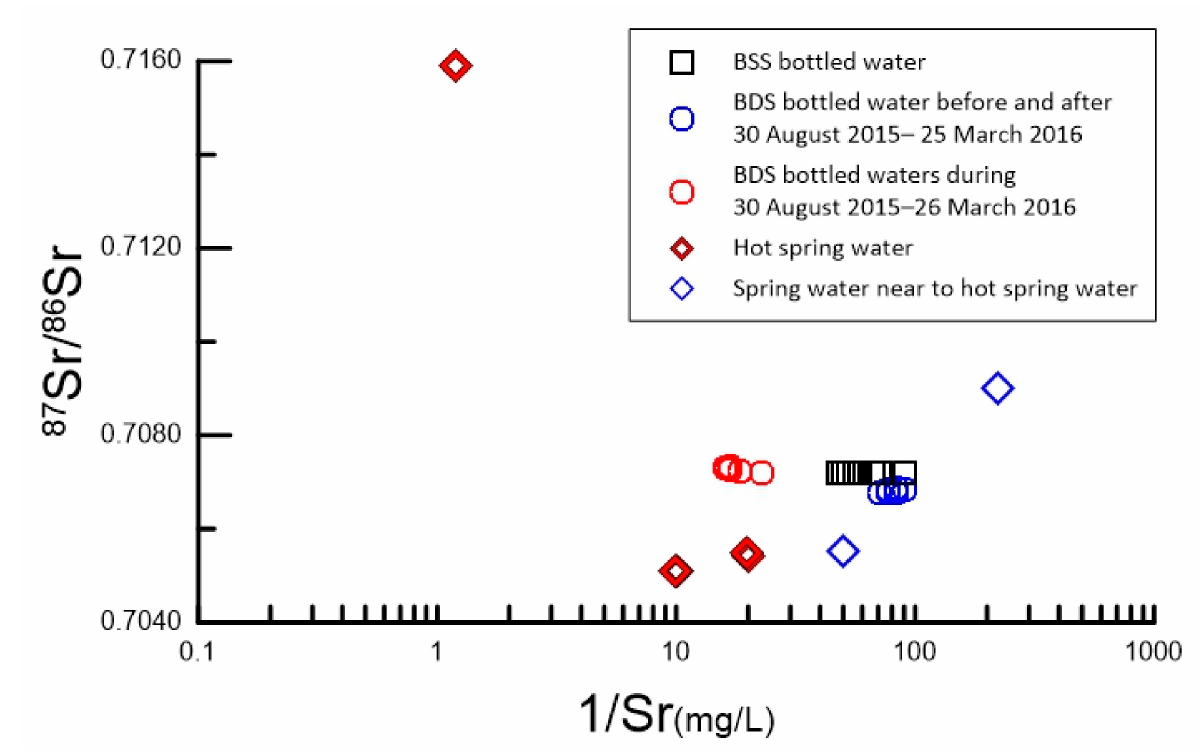
Figure 9. 87 Sr/ 86 Sr ratios vs 1/Sr concentrations (mg/L) of the bottled waters in the Mt. Baekdu area from April 2015 to September 2016. The 87 Sr/ 86 Sr ratios of the BDS bottled waters (red circles) from 30 August 2015 to 26 March 2016 are higher than those (blue circles) of before and after the period. However, the BSS bottled waters (rectangles) have almost same values in 87 Sr/ 86 Sr ratios. The data of hot spring waters and cold spring waters were used from this study (Table S1) and Han and Huh